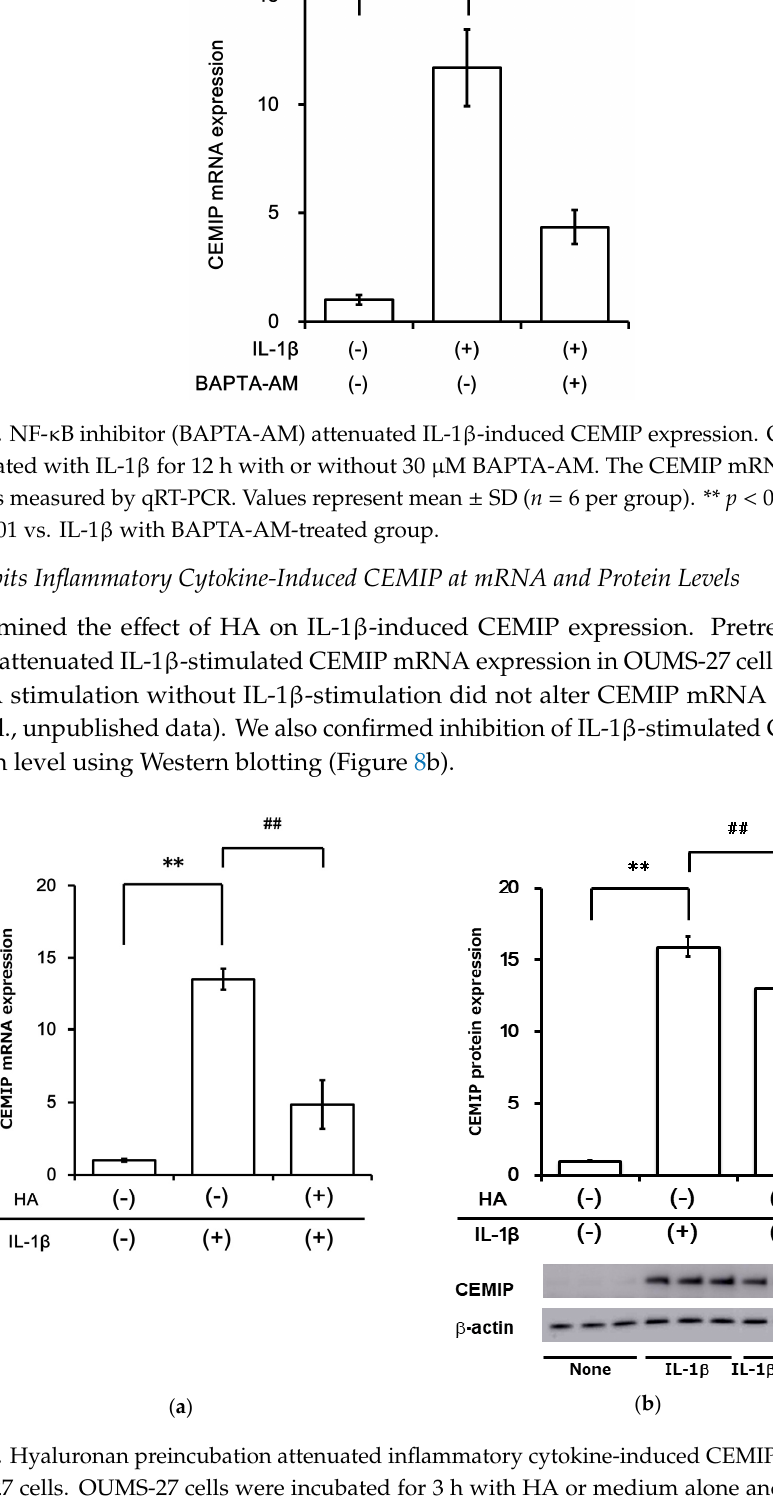
Figure 6. IL-1 β induces translocation of NF- κ B (p65) from cytoplasm to nucleus. OUMS-27 cells were seeded in collagen-coated chamber for 48 h. After 24 h of serum starvation, OUMS-27 cells were stimulated with IL-1 β for 12 h. NF- κ B p65 (green) was detected by immunocytochemistry (green) and nuclei were stained with Hoechst 33258 (blue). Merged images are shown at the bottom.